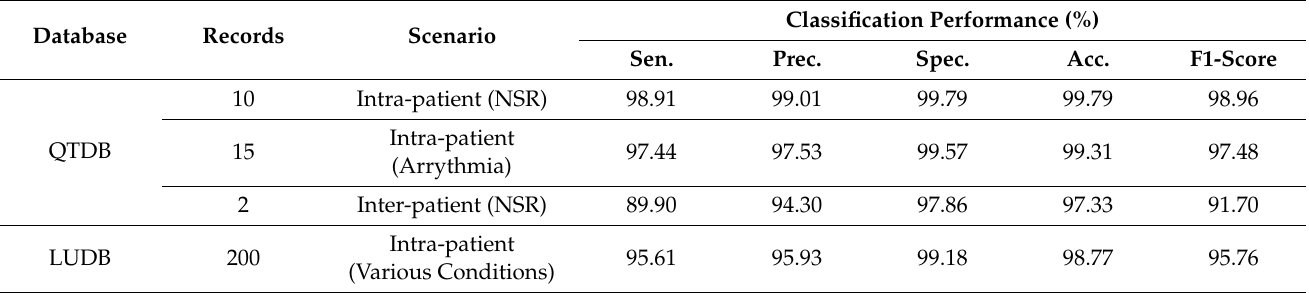
Table 4. Delineation results in an intra–inter patient with NSR, arrhythmia, and various conditions using the QTDB and the